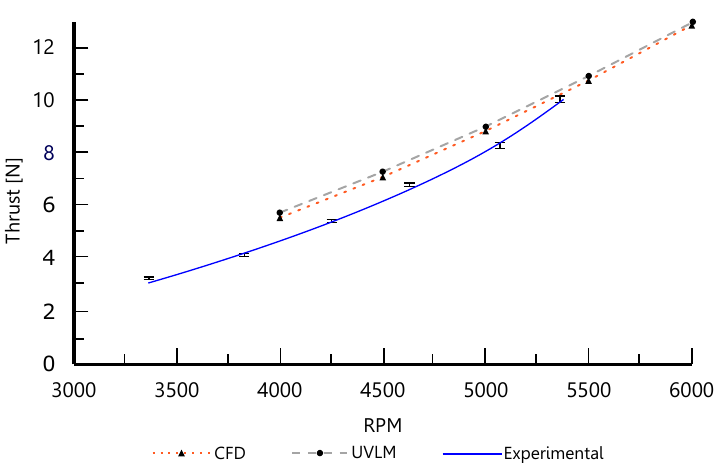
Figure 15. Experimental and computational